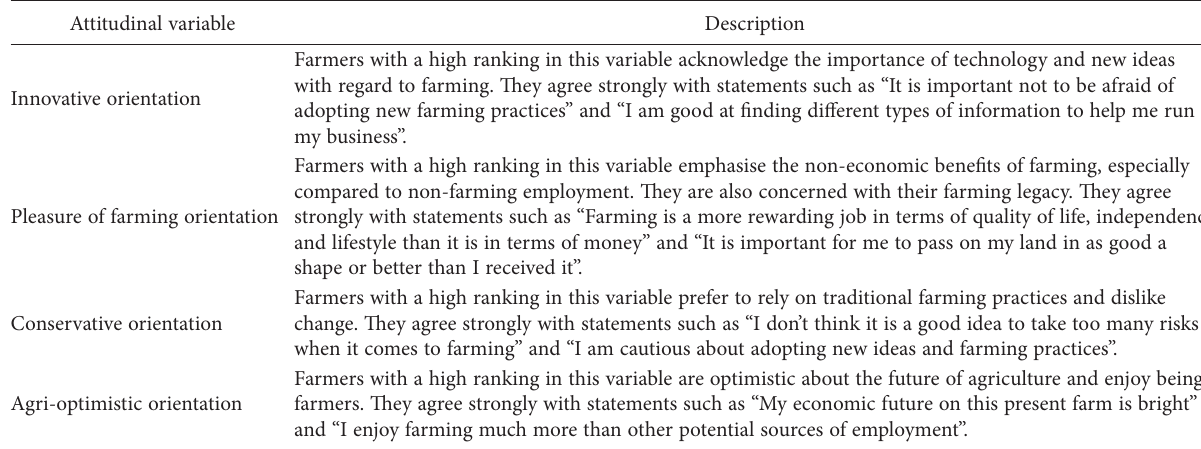
Table 2. Description of attitudinal variables.